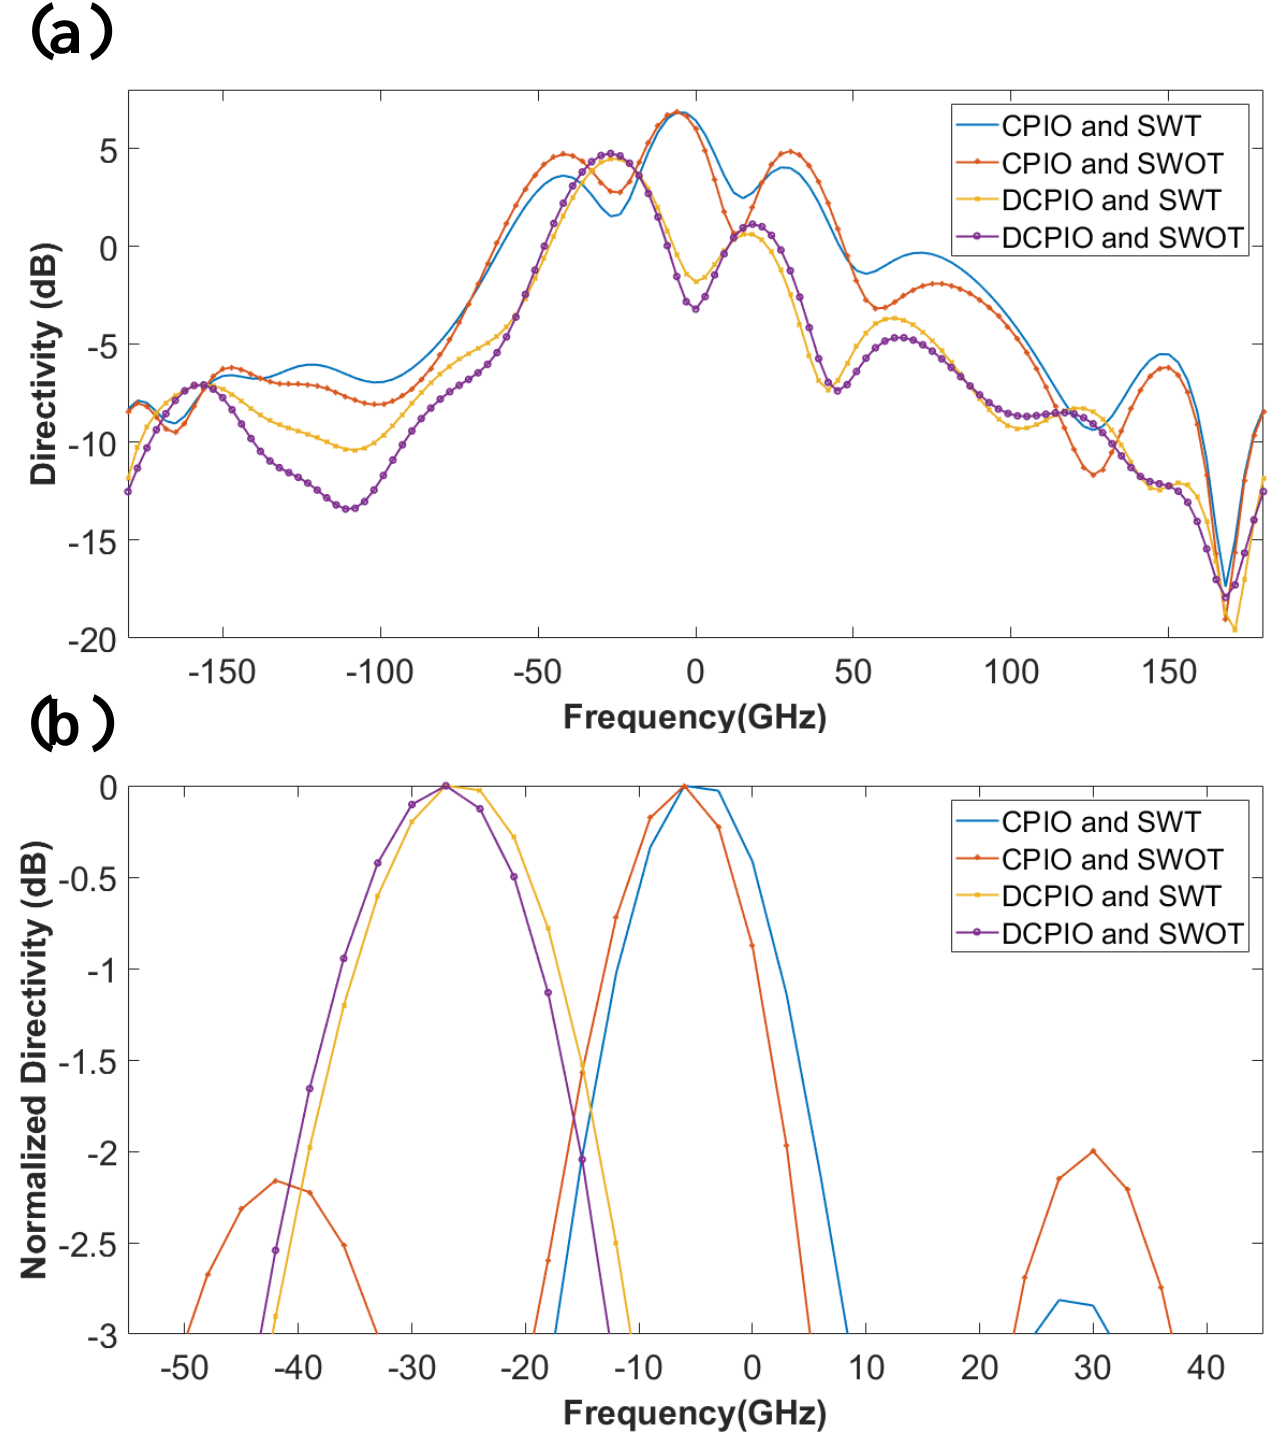
Figure 10. Directivity plot using the Rogers RT Duroid 5880 substrate for the range of −180° to +180°. The maximum directivity and the normalized directivity for all of the modes are 6.86 dB with 24° and 7°, 6.84 dB with 15°, 25°, 14°, and 4.47 dB with 32° and 4.74 dB with 29°.